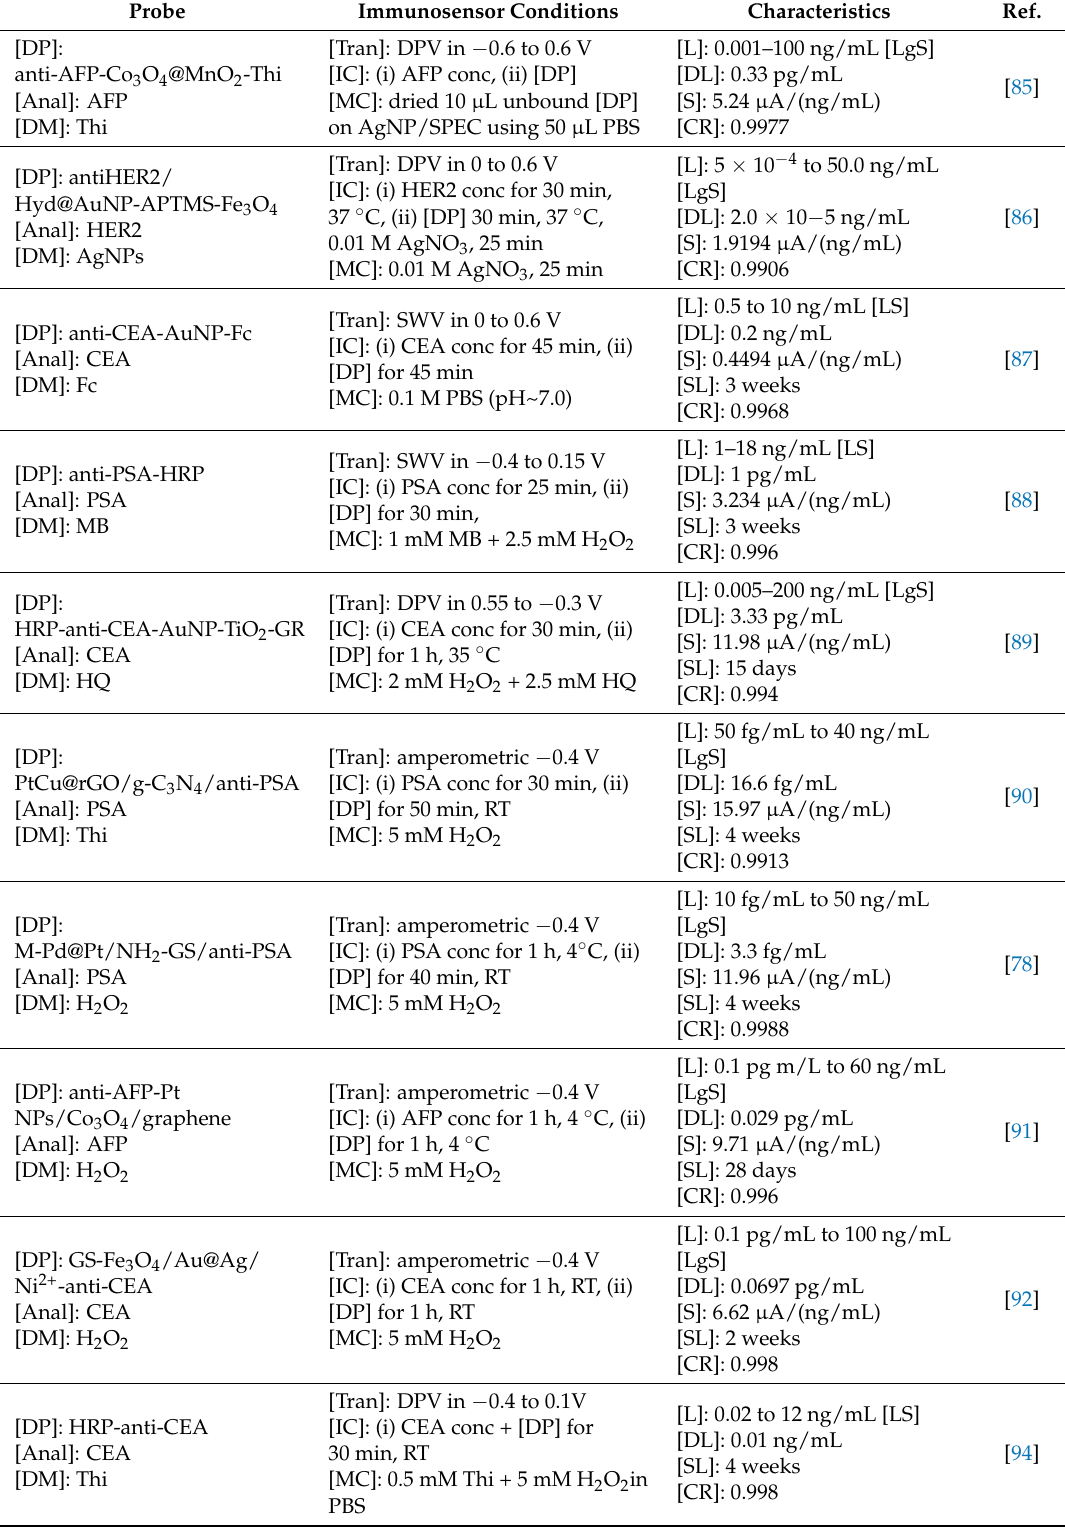
Probe Immunosensor Conditions Characteristics